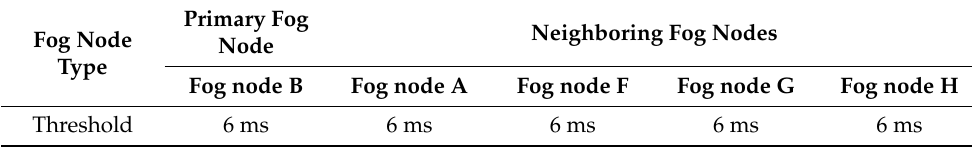
Table 3. Example of Offloading Threshold set for Fog Node B and its